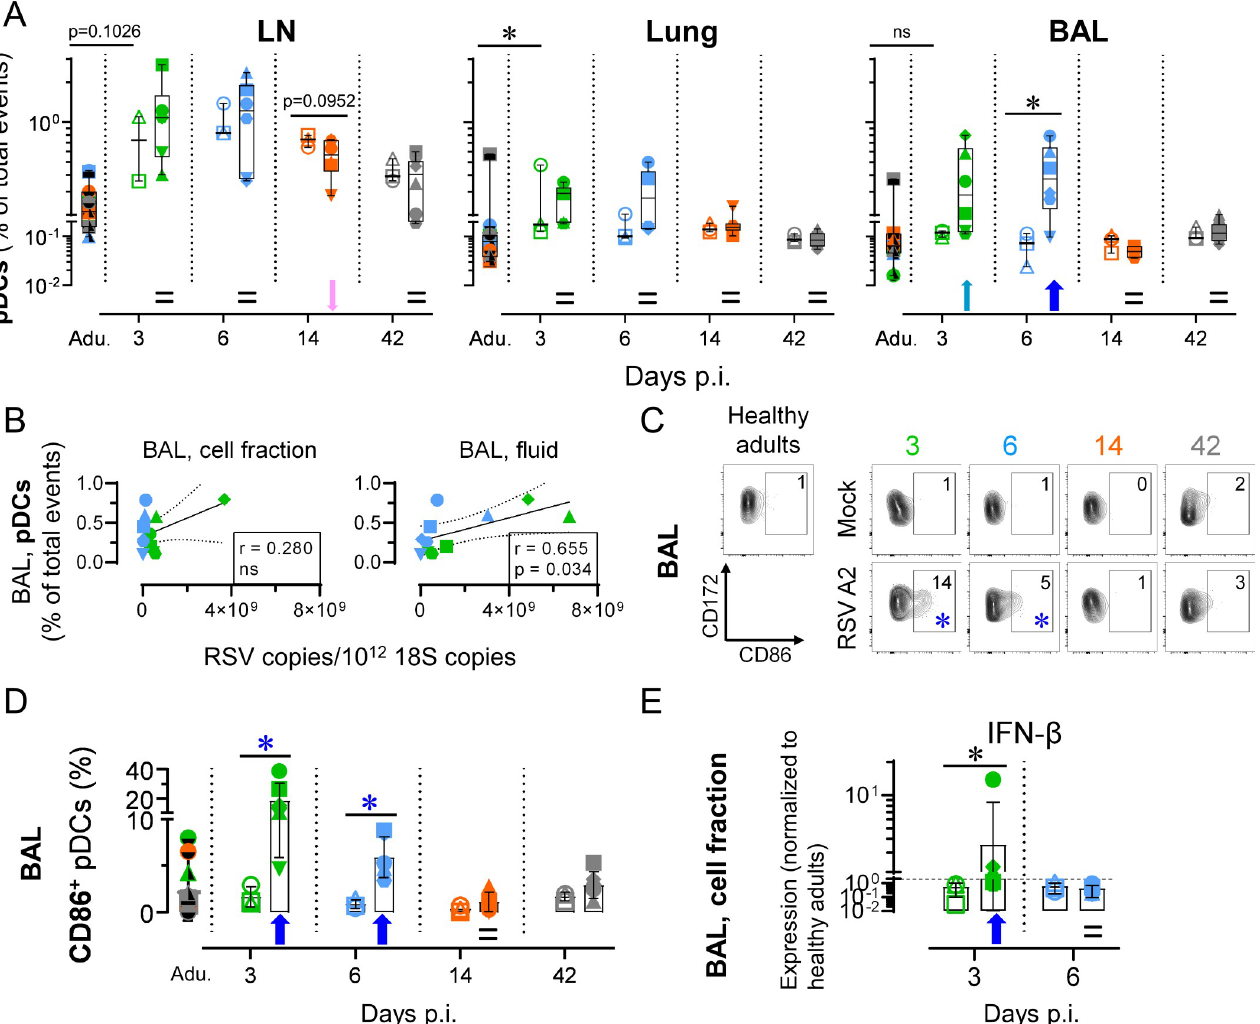
Fig 2. Neonatal RSV A2 infection induces bronchoalveolar space recruitment of activated pDCs. (A) Neonatal RSV A2 infection induces an early and transient bronchoalveolar space colonization by pDCs, but not in peribronchial LNs or lung tissue. (B) Correlation coefficient (r) obtained with pDC counts calculated as a function of RSV A2 copies/10 12 18S copies. Significance was reached for BAL fluid but not for BAL cellular fraction. (C-D) A high frequency of recruited pDCs in bronchoalveolar space upregulate CD86. (C) Representative FCM contour plots. Numbers indicate the mean percentage of animals per group per time point. Blue asterisks indicate significant differences between RSV A2 and Mock groups for a given time point. (D) As in (C), but with plot displaying all individuals. (E) Type I IFN quantification by qPCR in the BALs of RSV A2 infected neonates and healthy controls. (A-E) Each symbol represents an individual animal (healthy adults, n = 12; mock neonates, n = 3 per time point; neonates infected with RSV, n = 6 per time point). Boxplots indicate median value (center line) and interquartile ranges (box edges), with whiskers extending to the lowest and the highest values. Adu., healthy adults. Groups were compared using Mann–Whitney U-tests (A, C-E). Stars indicate significance levels. � , p <